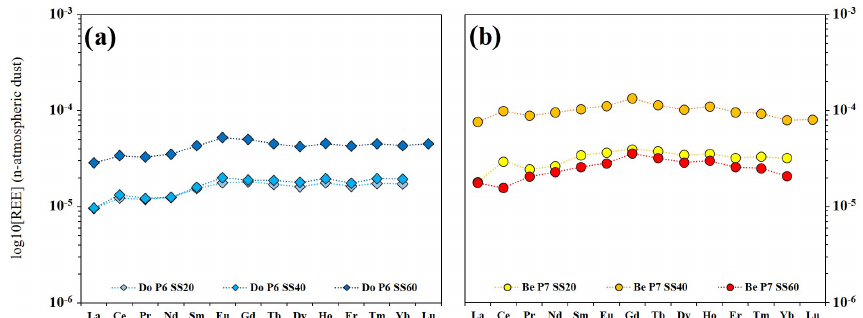
Figure 7. Patterns of the average concentrations of rare earth elements in soil solutions of DoP (a) and BeP (b) . REE concentrations have been normalized by the values in the local atmospheric